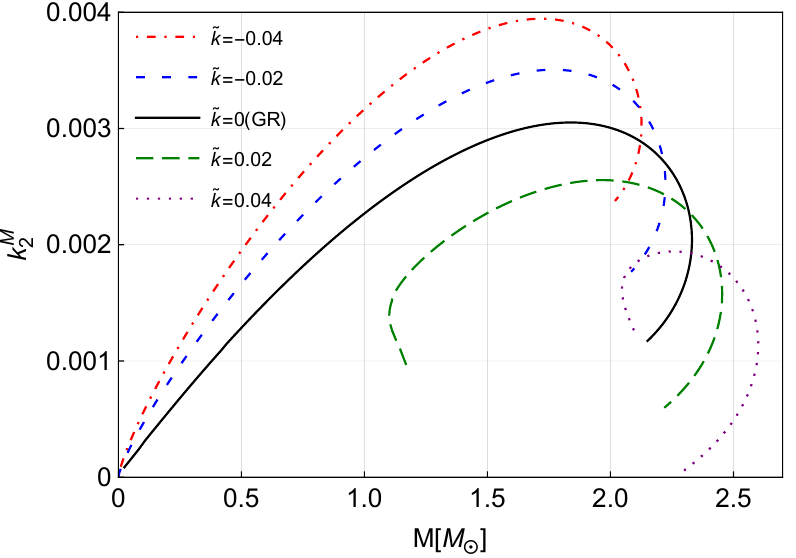
Figure 2. The magnetic-type quadrupolar TLNs k M for different values of the parameter ˜ k , where we choose the adiabatic index Γ =